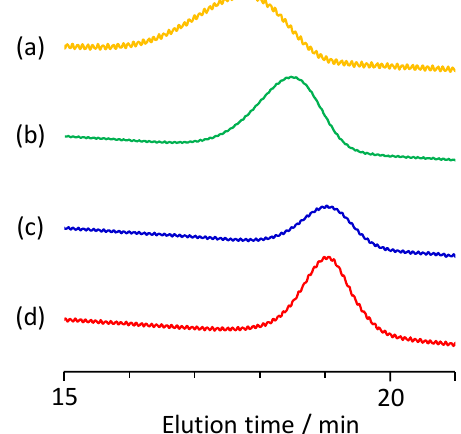
Figure 3. Gel permeation chromatography (GPC) traces of poly(IA- co -10-HHIA)s. ( a ) Code 1, ( b ) code 2, ( c ) code 3, ( d ) code 4. Table 1. Synthesis of poly(IA- co -10-HHIA)s with different monomer feed ratios.